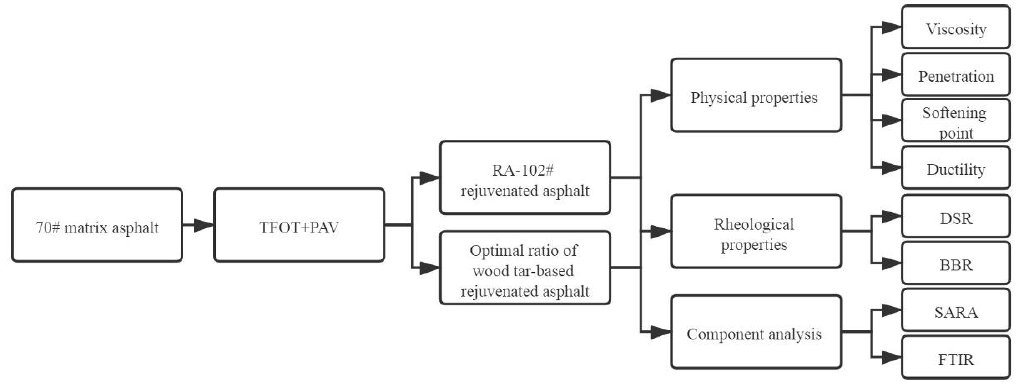
Figure 3. Test scheme.